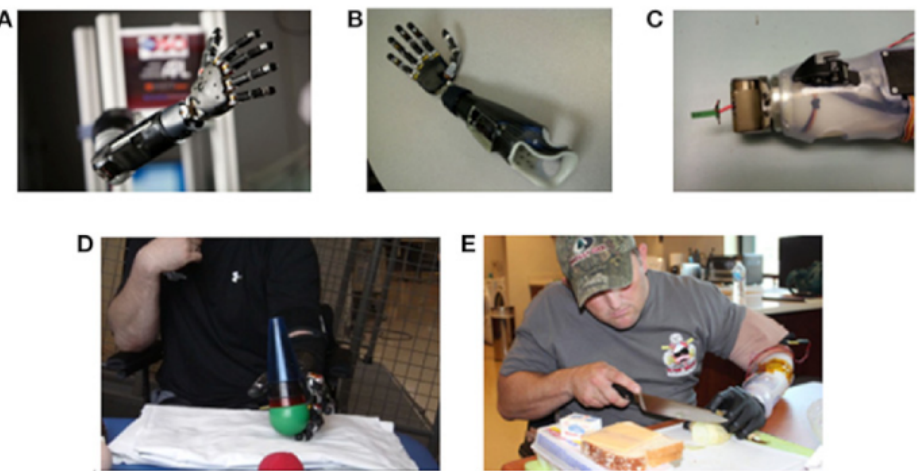
Figure 4. ( A – C ) Different components and configuration of the Modular Prosthetic Limb (MPL), built by Johns Hopkins University’s Applied Physics Laboratory, Baltimore, MD, USA. ( D , E ) An amputee performing reaching, grasping, manipulation and cooking tasks using the MPL. Reprinted with permission from [23].